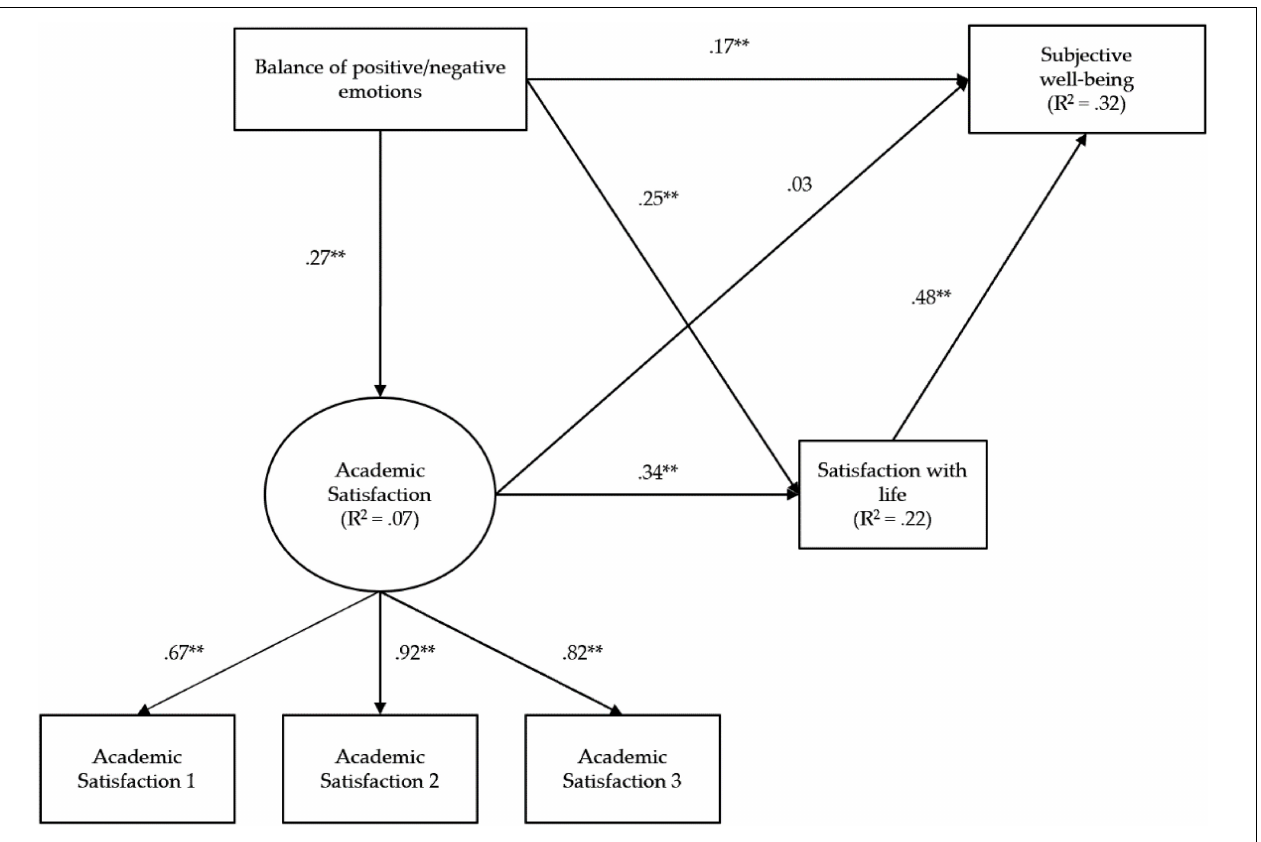
FIGURE 2 | Contribution of academic satisfaction on the subjective well-being model. Standardized path coefficients. ** p <